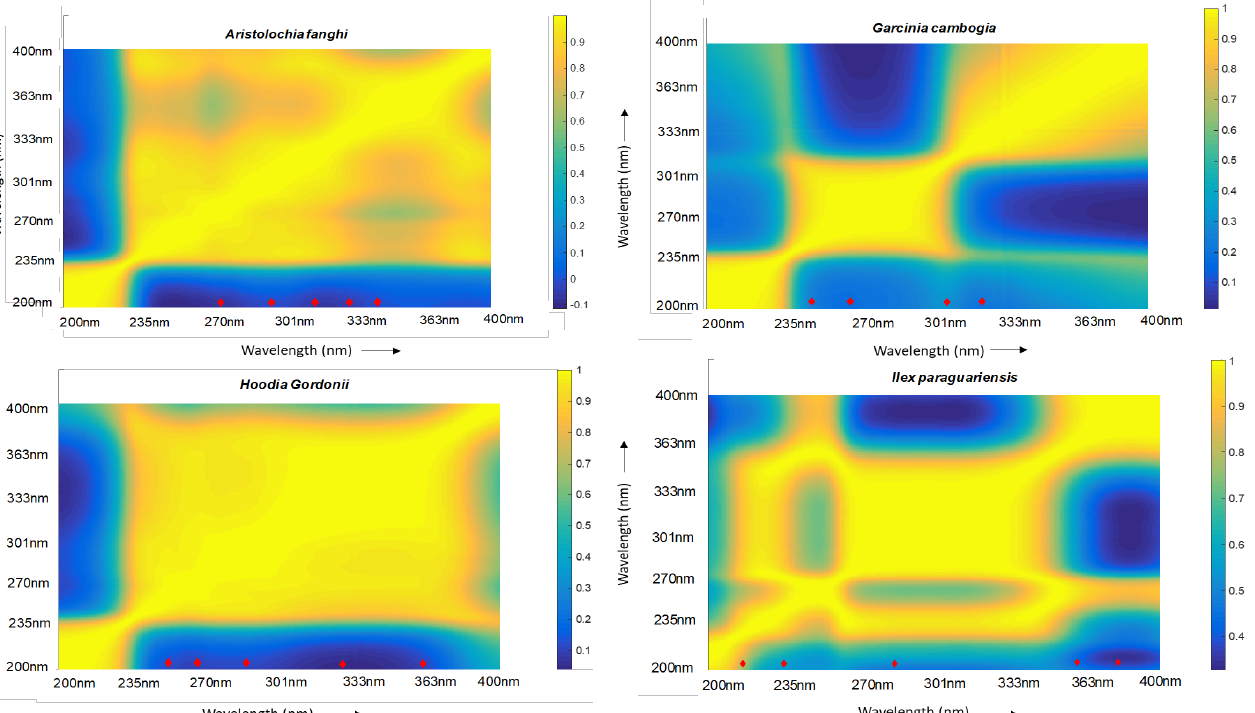
Figure 1. Colour map for Aristolochia fanghi , Garcinia cambogia , Hoodia gordonii , and Ilex paraguariensis depicting the correlation between wavelengths. The colour scale represents blue as “highly uncorrelated” and yellow as “highly correlated” wavelengths. The axis forms the wavelengths in nm. The red marker represents an approximation of the selected wavelengths on the colour map for the individual plants. The wavelengths are listed in Table